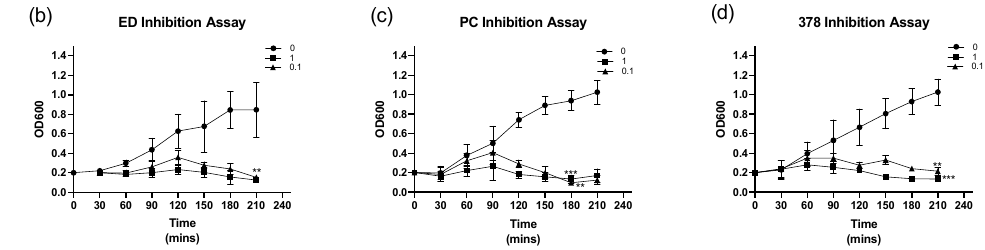
Figure 4. Kinetic of bacterial growth in the presence of phage APTC-EC-2A. Four bacterial strains: ( a ) XL10 Gold, ( b ) ED, ( c ) PC, and ( d ) 378 were tested against APTC-EC-2A at the concentration of 0 (without phage), 1 and 0.1 MOI. Error bars represent the standard deviation ( n = 3) for 240 min. Significance was determined by one-way ANOVA with Dunnett’s multiple comparisons test in comparison with untreated biofilms; p < 0.01 (**) and p < 0.001 (***).